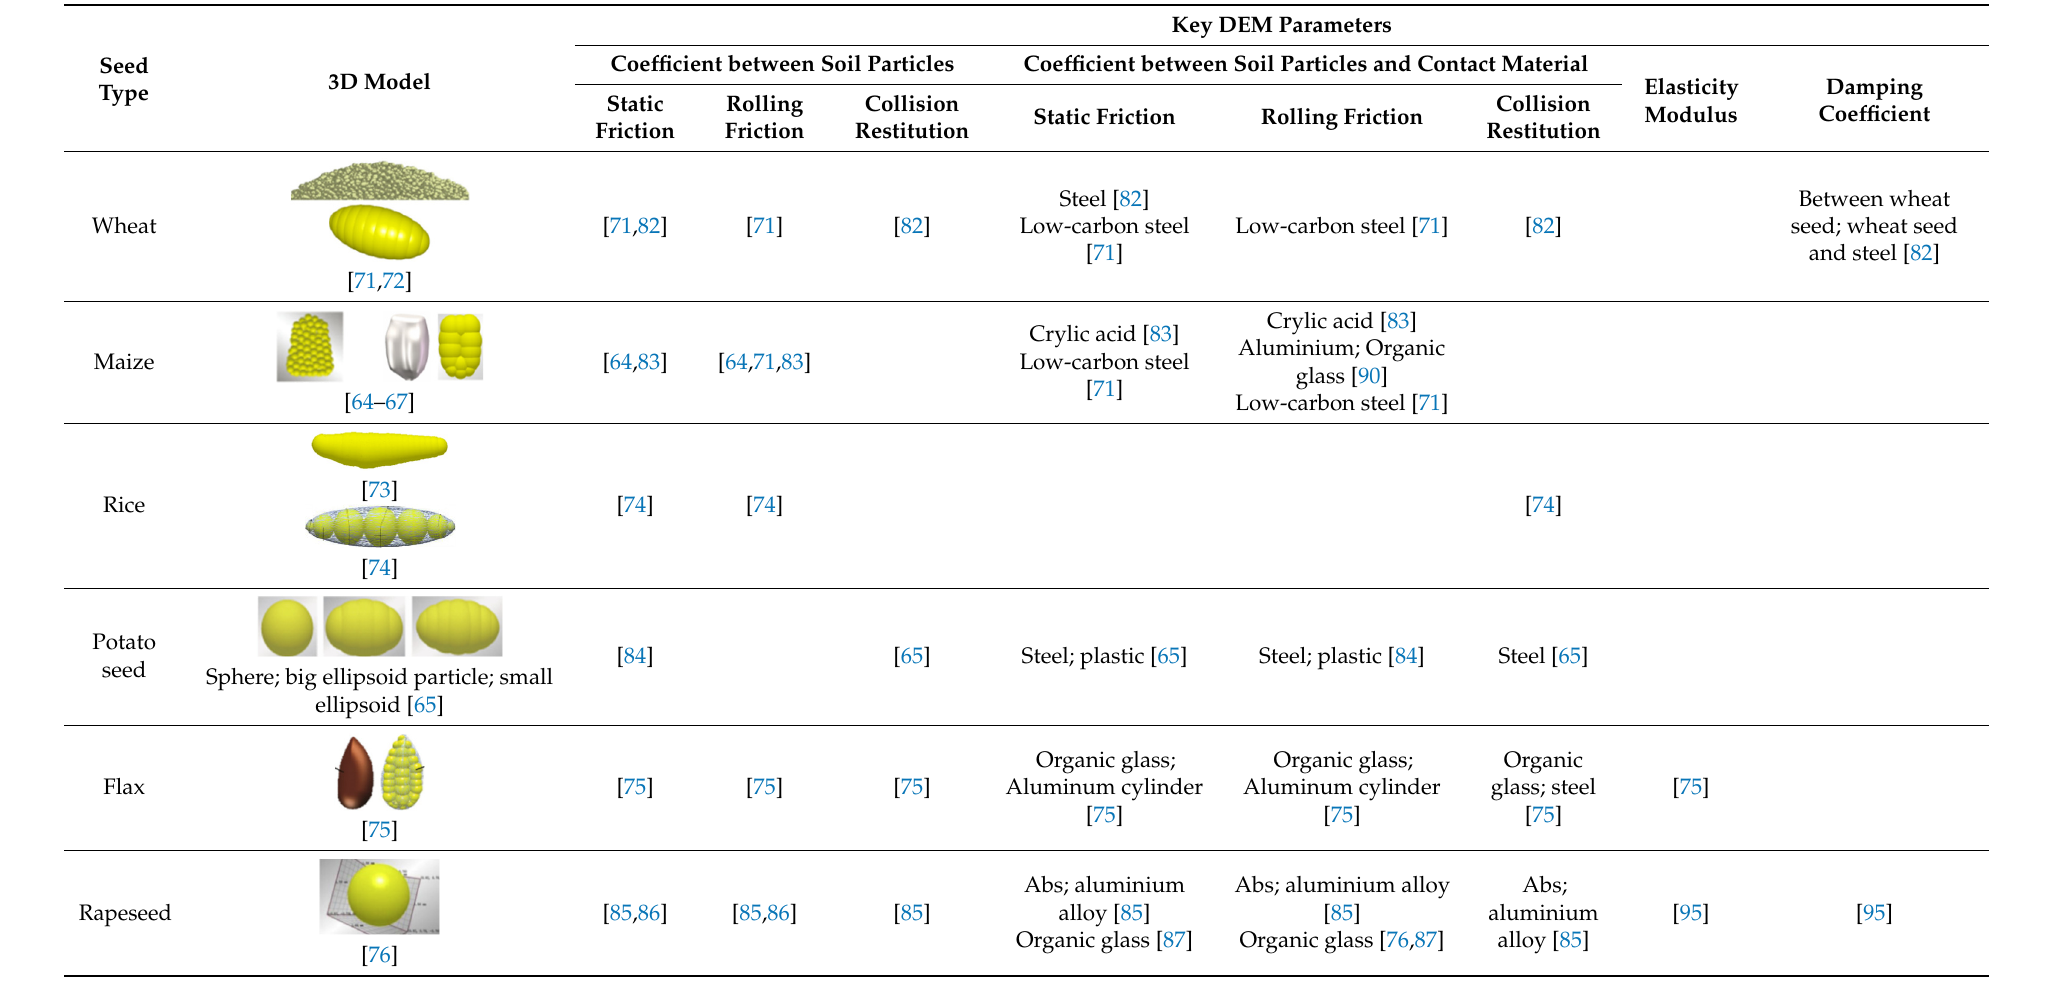
Table 2. DEM model and key parameters of common crop seeds.